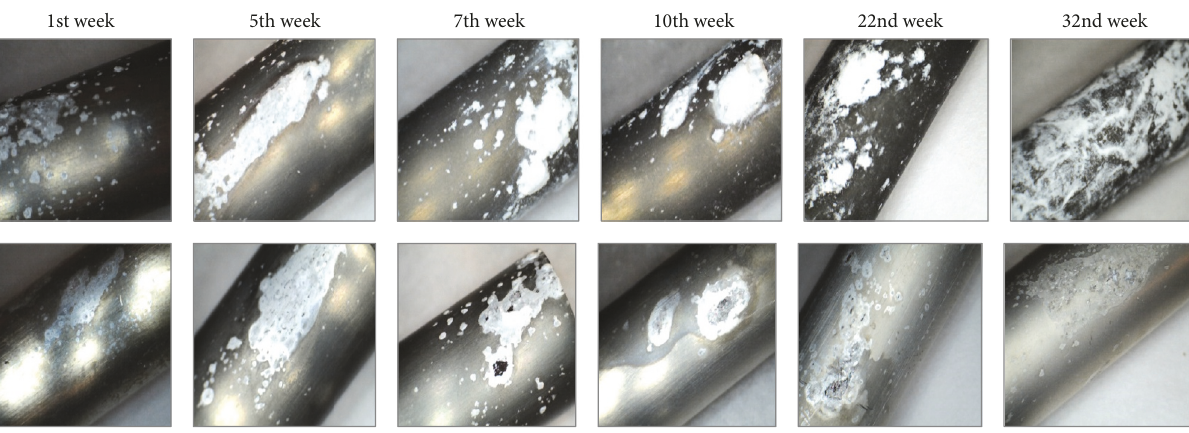
Figure 4: Visual images of Al 2024 specimens after immersion in the Red Sea water at different time intervals.